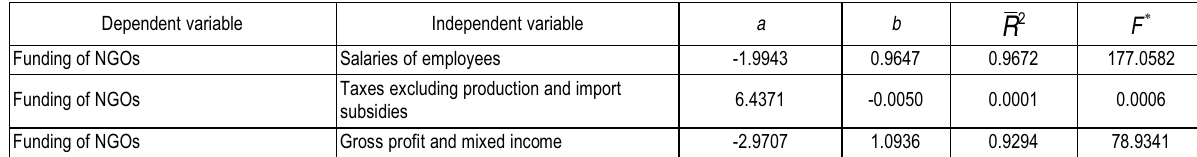
Table 4.The study of paired relation between the index of funding of NGOs and GDP indices (according to distribution method) * Dependent variable